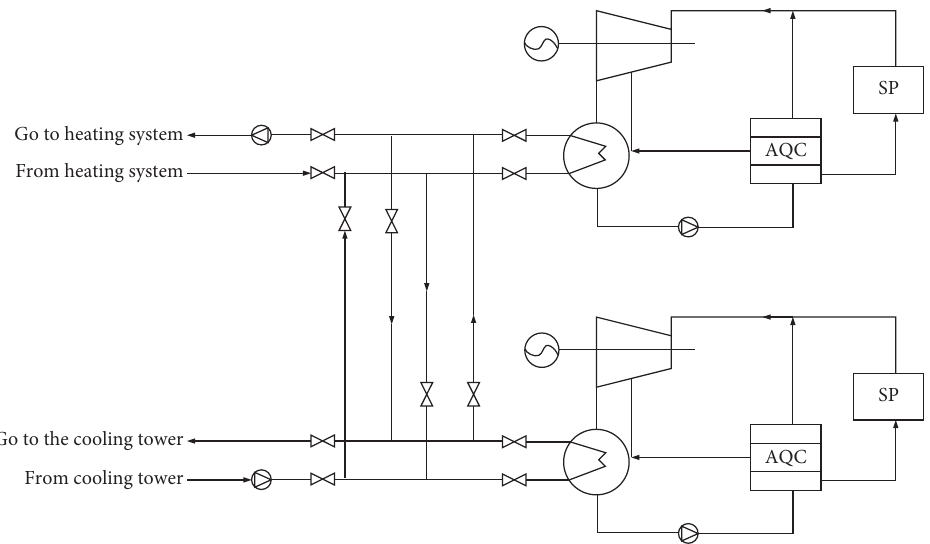
Figure 6: Schematic diagram of operating thermal system of waste heat power generation system.